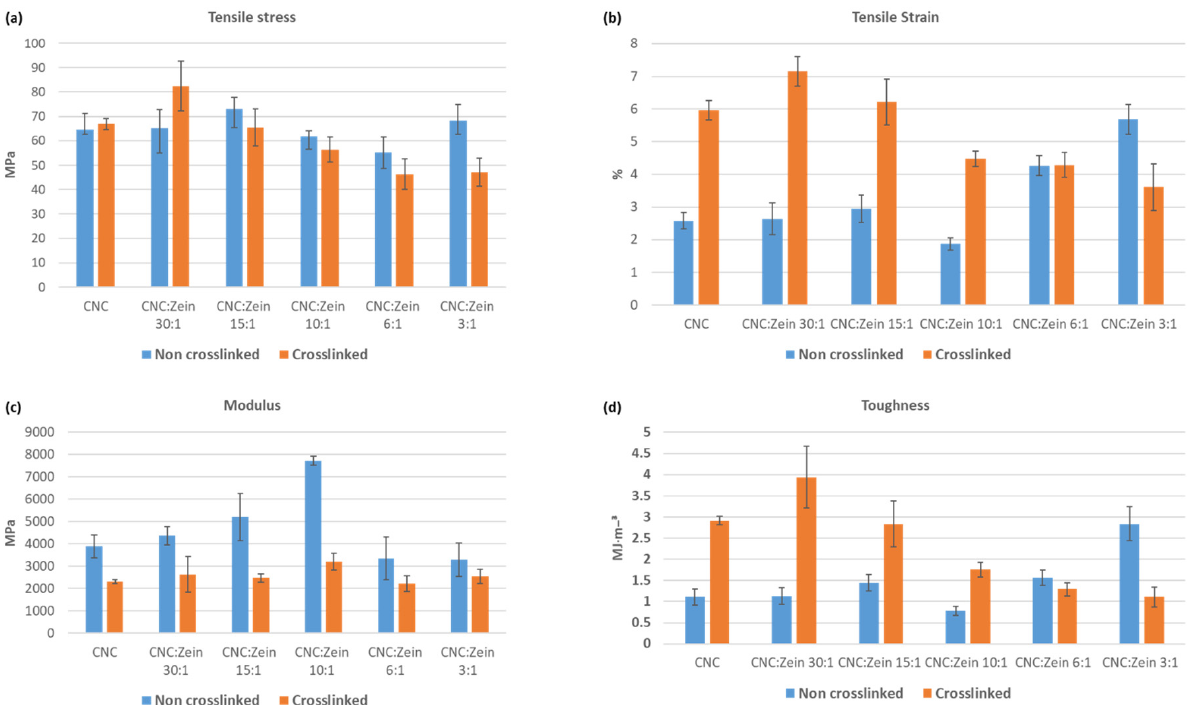
Figure 11. Tensile testing of crosslinked and non-crosslinked CNC films, nanocomposite CNC \ CZ films ( a ) Tensile stress at break, ( b ) tensile strain at break, ( c ) Young’s modulus and ( d ) toughness.